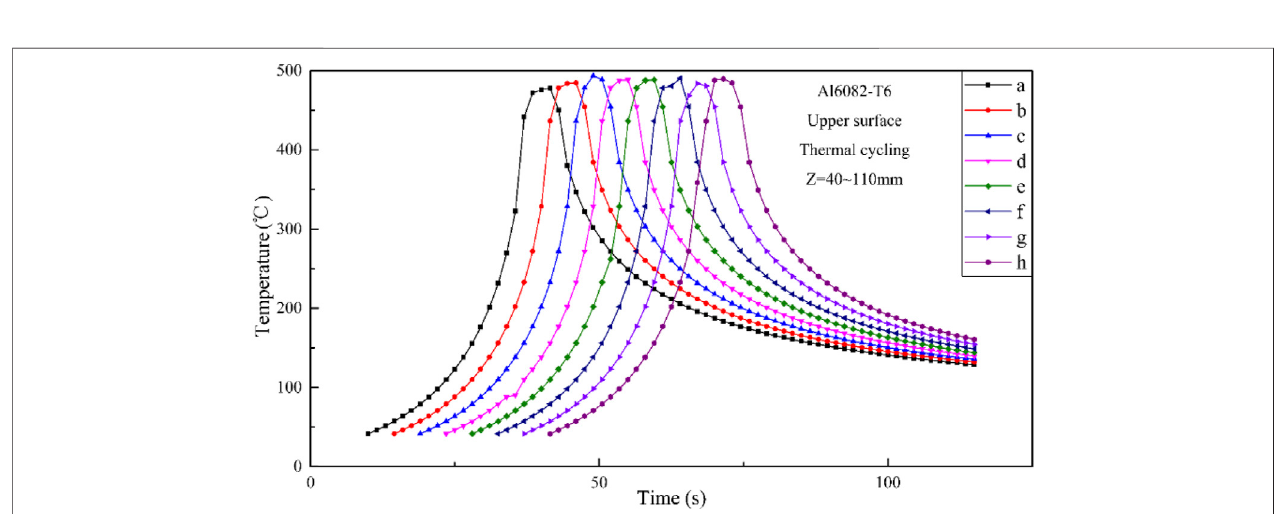
FIGURE 12 | Thermal cycle curves of each feature point on the upper surface of the workpiece along the welding direction.